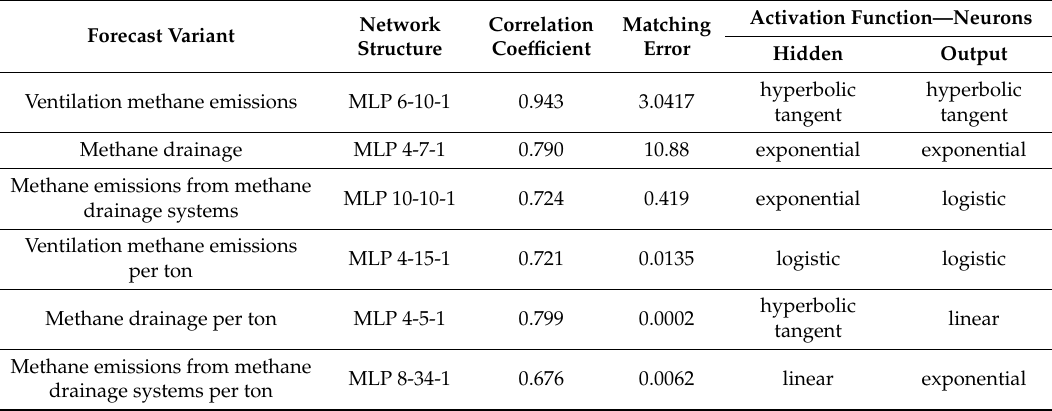
Table 5. List of neural network structures used for the